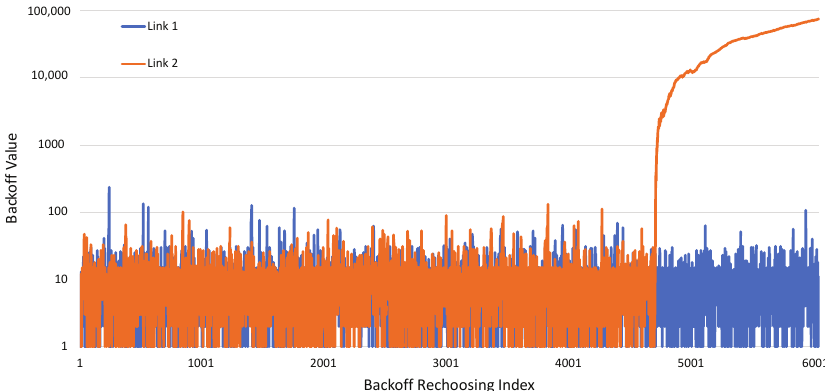
Figure 2. Backoff count evolution example for two links of an MLD.